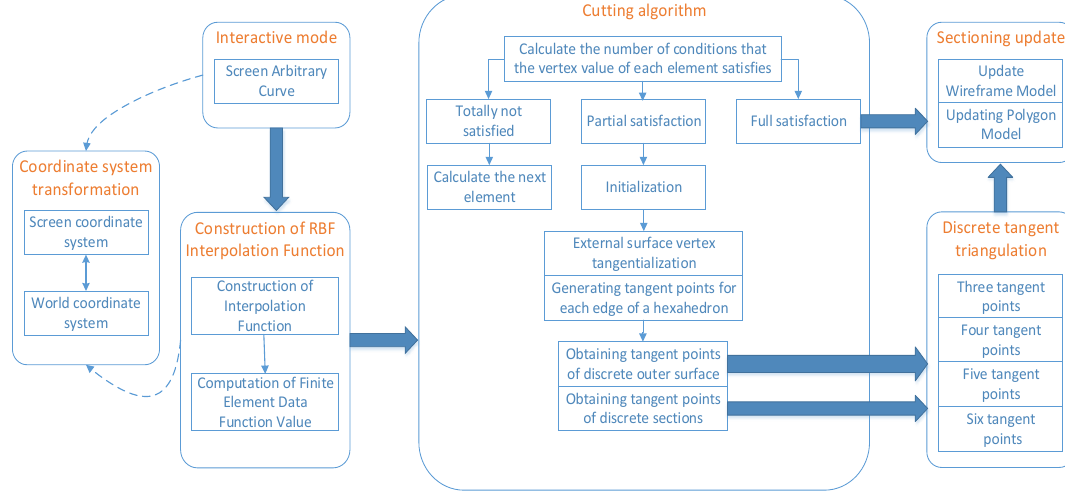
Figure 1. Visualization method for arbitrary cutting based on radial basis function